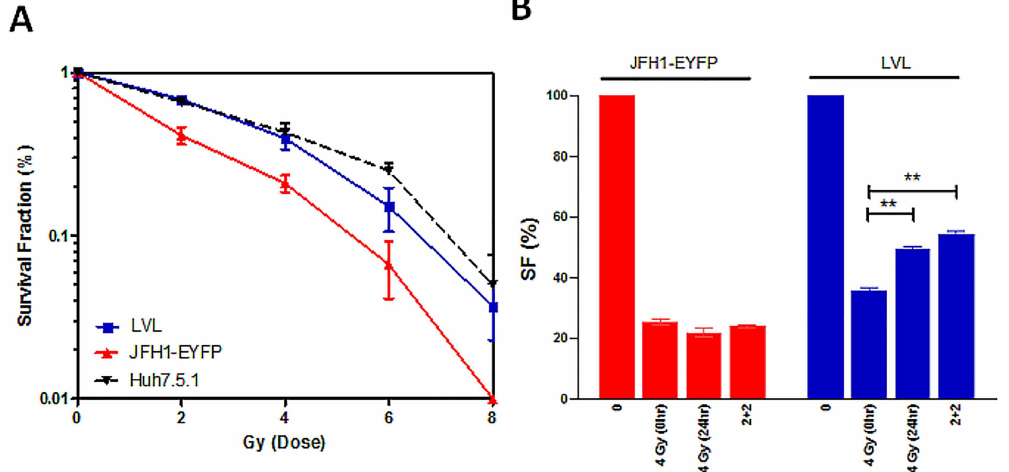
Fig 5. LVL cells increase resistance to RT. The survival curves following (A) single dose or (B) fractional irradiationwere assayed by the colonogenic assay. ** P <